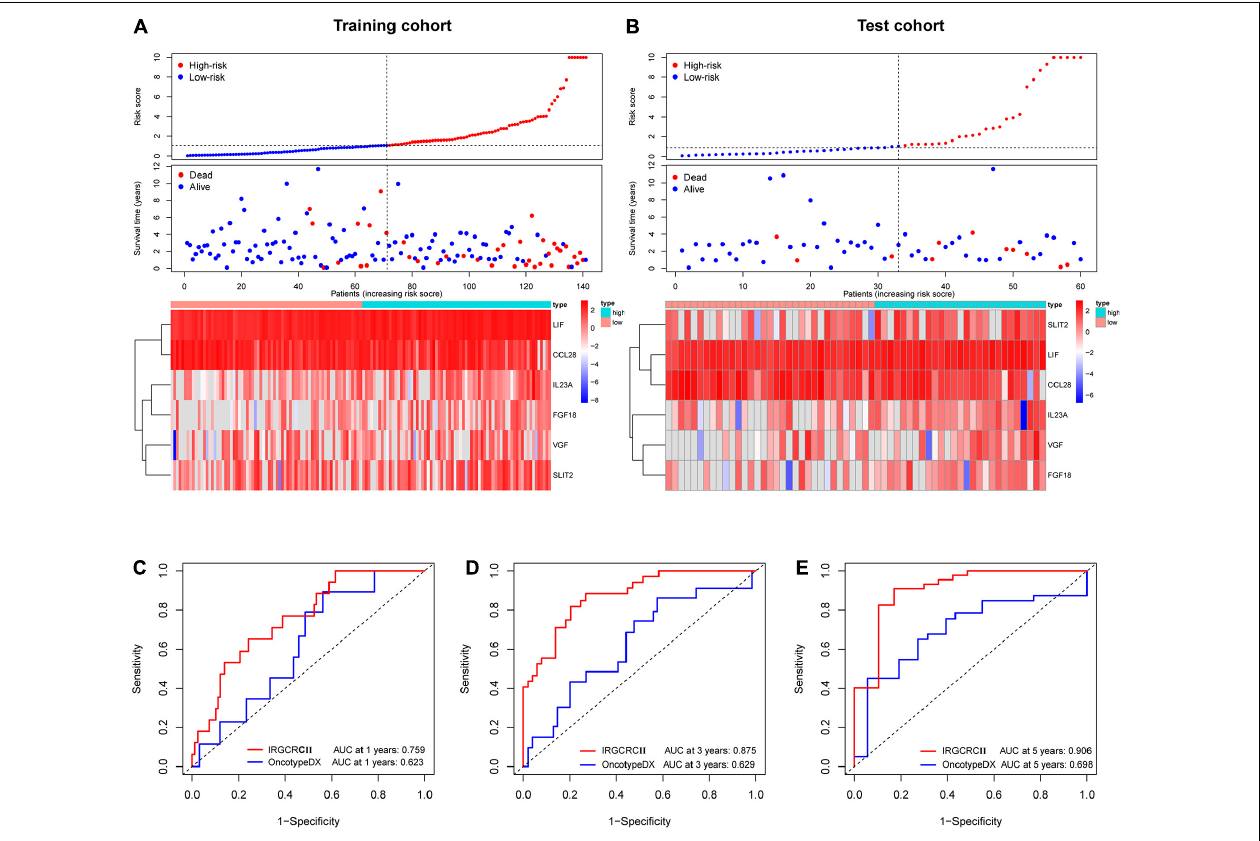
FIGURE 4 | Risk plot for the training and test cohorts and comparison of the IRGCRC and OncotypeDX colon models. Distribution of the risk score, survival status, and gene expression data in the training and test cohorts (A,B) . Time-dependent ROC curve analysis at 1- (C) , 3- (D) , and 5-years. (E) DFS for the IRGCRCII model and OncotypeDX colon model in the training cohort. ROC, receiver operating